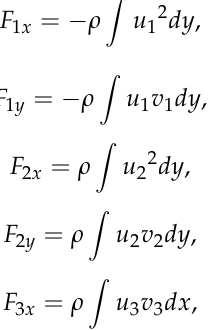
Figure 7. Setup for measurement of flow velocity fields using the PIV system: ( a ) connection diagram; ( b ) side view from the camera.